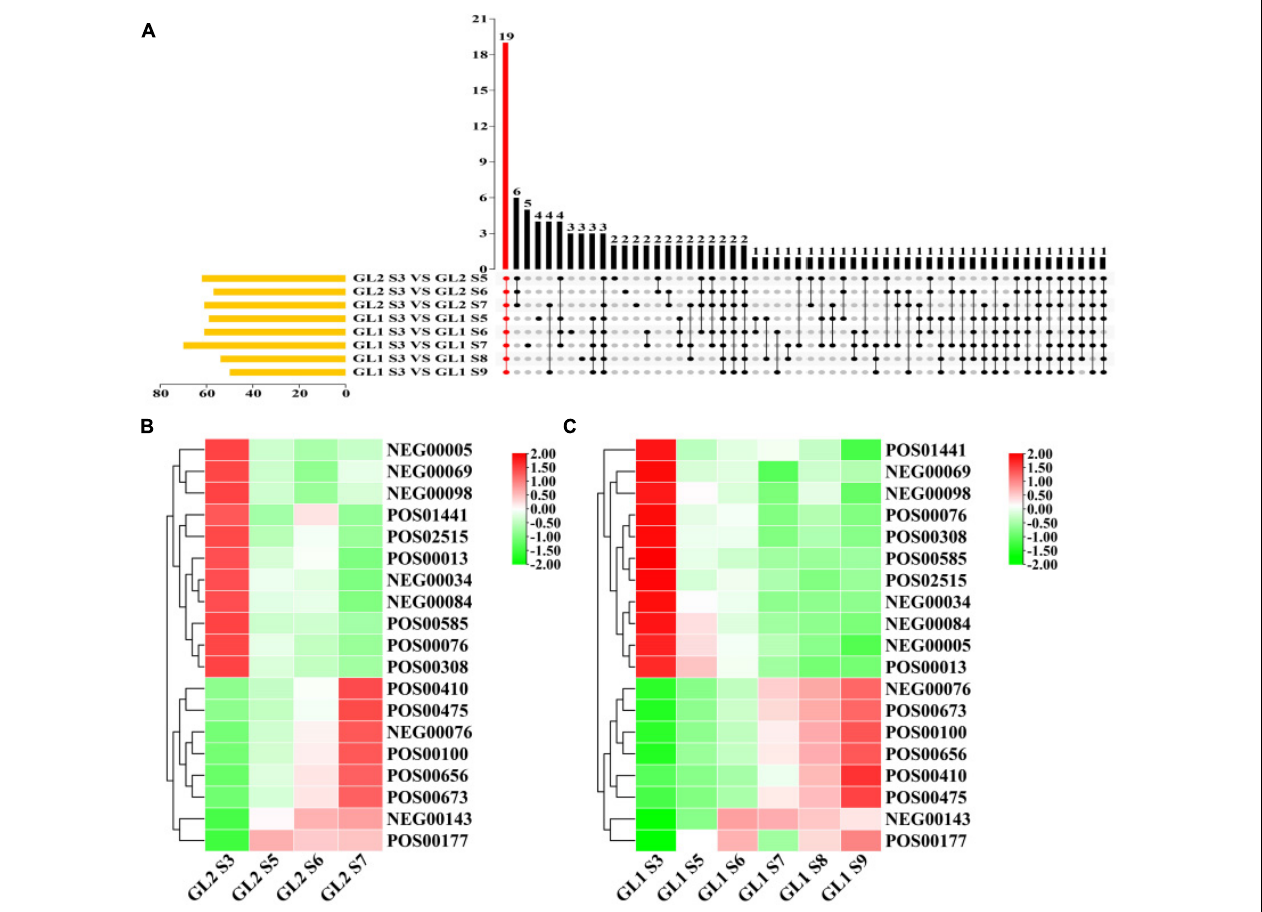
FIGURE 3 | Upset analysis of maturation-related metabolites (A) and heat map of expression levels of metabolites on ‘Ganlv 2’ (B) and ‘Ganlv 1’ (C) . In (A) the yellow bar on the left represents the number of metabolites in the comparison group. The black dots on the right represent that these metabolites appear in the corresponding group, and the gray dots represent not. Metabolites present in all comparison groups were marked in red. In (B,C) the bar on the right represents the normalized coefficient range of the expression level. The redder the bar is, the higher the expression level, and the greener means the lower the expression level.